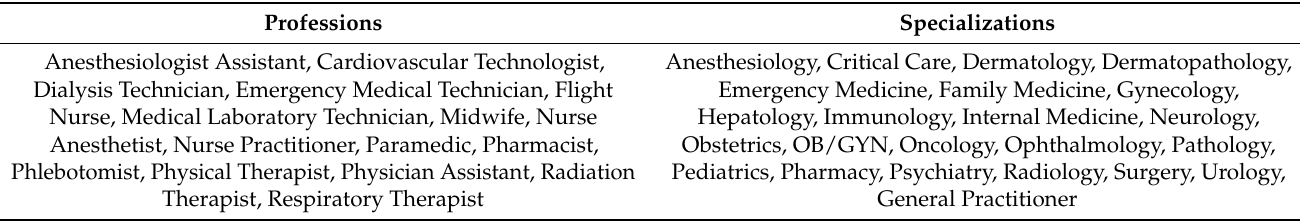
Table A1. List of professions and specializations of HCP points of interest.